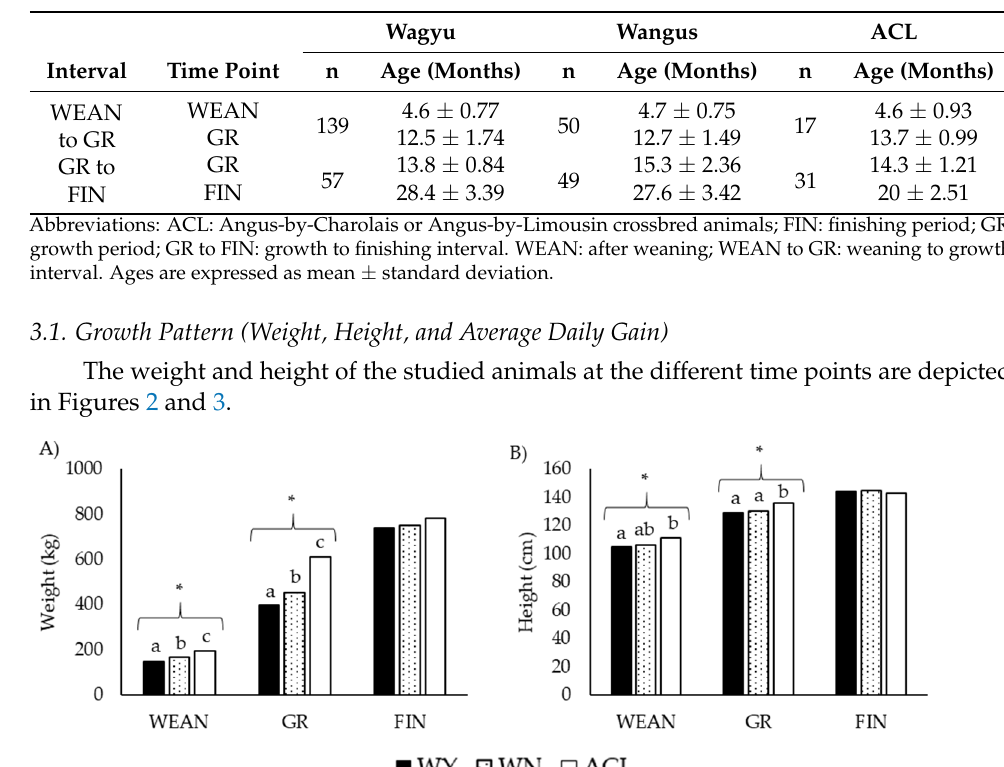
Table 4. Number and ages of fattening steers during each growth interval and time point (longitu- dinal approach). Table 4. Numberandagesoffatteningsteersduringeachgrowthintervalandtimepoint(longitudinalapproach).